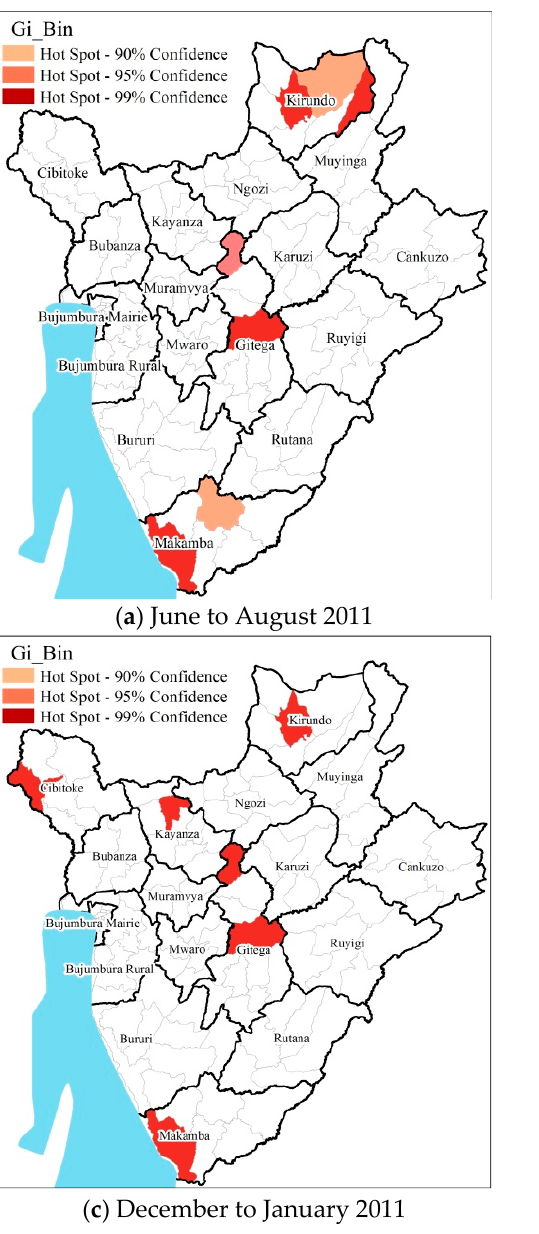
Figure 5. Results of seasonal scale hotspots analysis during the dry seasons ( a ) June to August 2011; ( b ) June to August 2012; ( c ) December to January 2011; ( d ) December to January 2012. All the statistically significant (at 90% and above confidence interval) hot spots have been highlighted in shades of red.